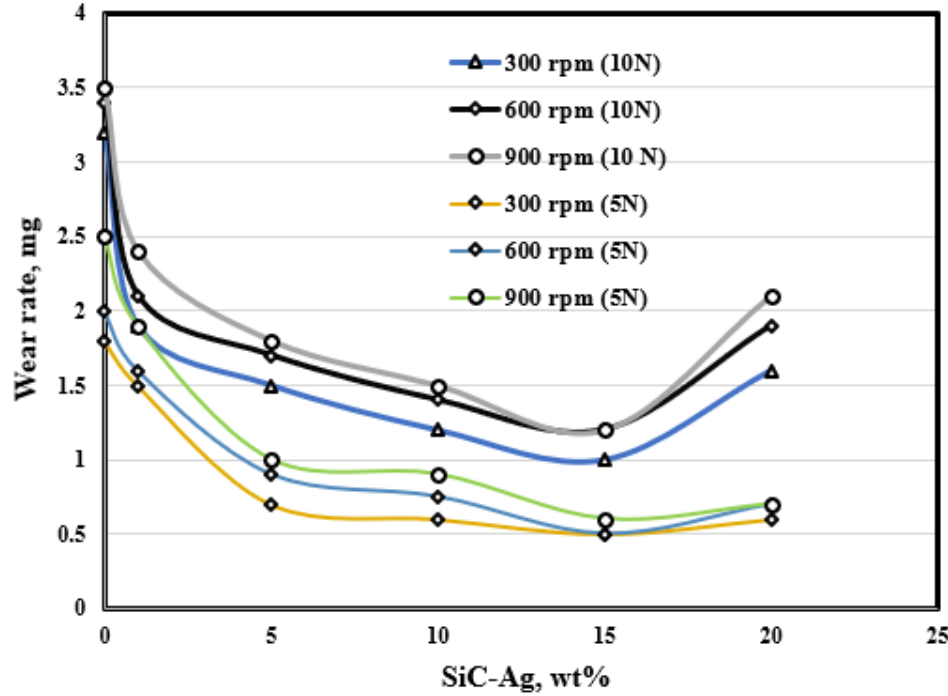
Figure 7. Wear rate (mg) of the fabricated materials at a load of 5 N and 10 N and different sliding speeds (600 rpm, 900 rpm, and 1200